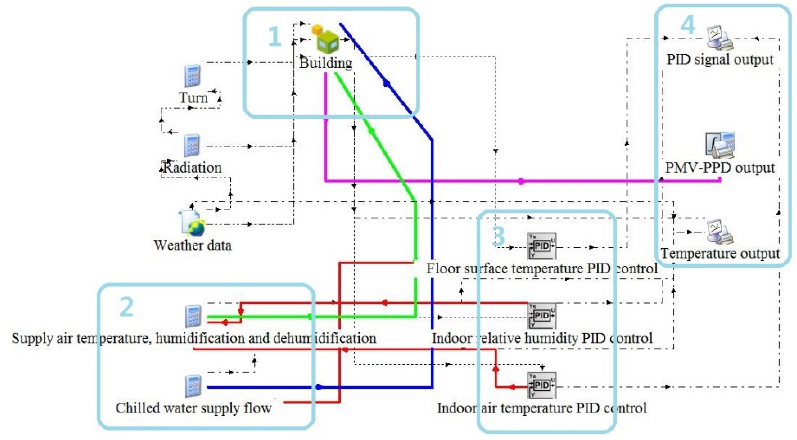
Figure 1. Numerical simulation diagram of the TRNSYS.